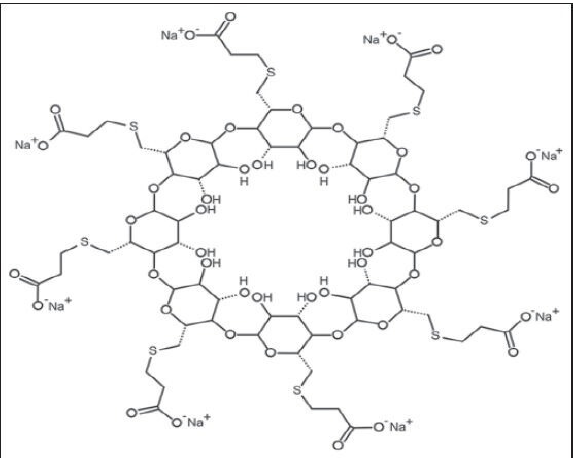
Figure 2. Chemical structure of